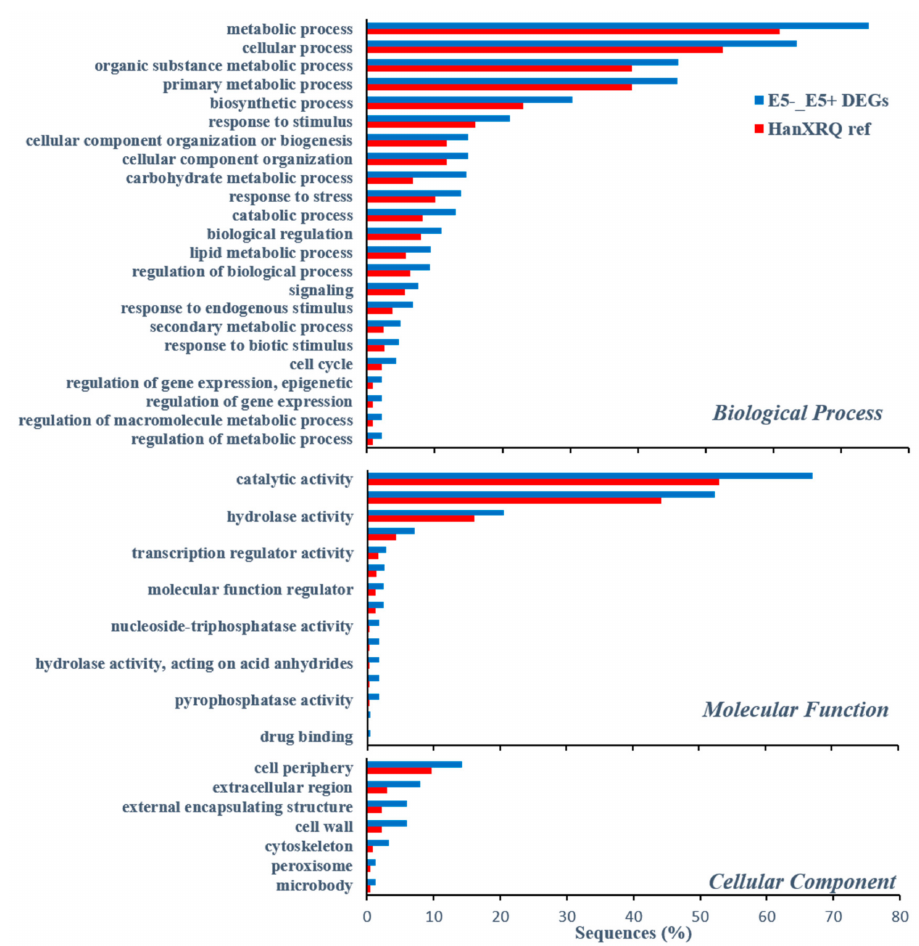
Figure 7. Distribution of enriched GO terms for differentially over-expressed genes (Fisher’s Exact Test) for DEGs of the resistant cultivar EMEK3 [i.e., genes that were differentially expressed between roots of EMEK3 five d post infestation with O. cumana (E5+) and non-infested roots (E5-)] compared with GO terms of whole reference-predicted gene annotation (HanXRQ). The Y-axis represents significant enrichment of GO terms and the X-axis shows the relative frequency of the